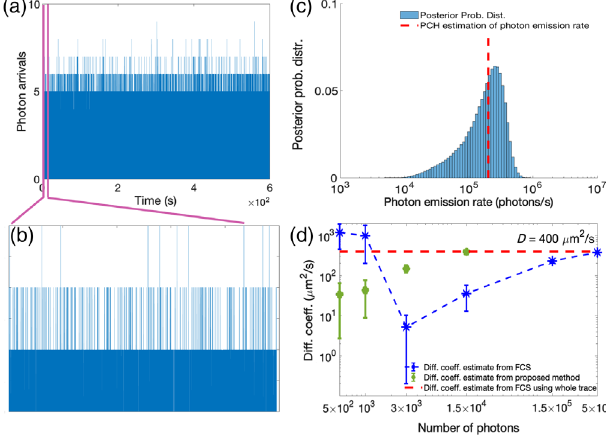
FIG. 18. Estimation of the diffusion coefficient and molecule photon emission rate for Cy3 dyes. (a) Experimental intensity trace (binned at 100 μ s) with concentration 1 nM of Cy3 dye molecules and 61% glycerol. A background photon emission rate of 600 photons = s is known from calibration. (b) Analyzed portion of the trace containing ≈ 3000 photon arrivals. (c) Pos- terior probability distributions and the value (red dashed line) of molecule photon emission rate determined by the photon count- ing histogram (PCH) method on the entire trace [59]. (d) Similarly to Fig. 1, we compare our method ’ s diffusion-coefficient estimate (green dots) to FCS (blue asterisk) as a function of the number of photons used in the analysis. Since by 1 . 5 × 10 4 photon arrivals our method has converged, we avoid analyzing larger traces. The red dashed line is the FCS estimate obtained from the entire 5-min trace containing ≈ 3 × 10 6 photon arrivals.